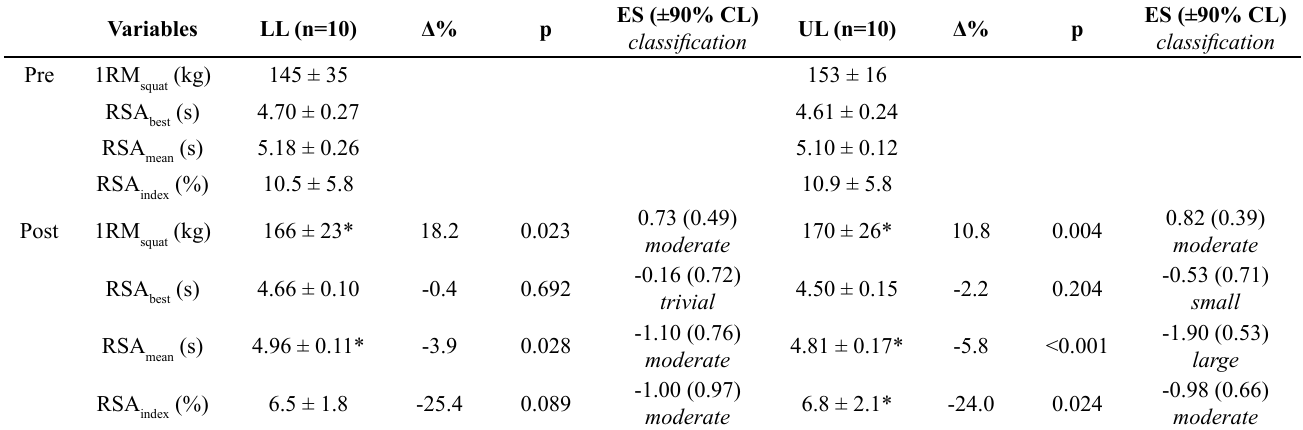
Table 3. Maximal strength and repeated sprint ability results before and after the linear (LL) and undulating loads (UL).